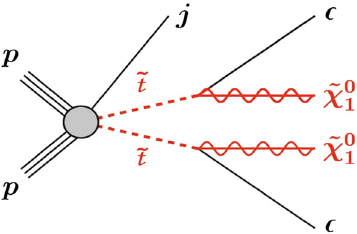
Fig. 7 The schematic diagram of the production process pp → ˜ t 1 ˜ t ∗ with the sequent decay ˜ t 1 → c ˜ χ 0